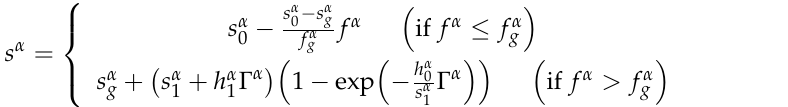
Figure 8. Comparison of the experimental and simulated response of the AZ31B Mg alloy during uniaxial loadings along the rolling direction. ( a ) Stress ‐ strain curves of uniaxial tension and com ‐ pression, ( b ) twin volume fraction of uniaxial compression (After Wu et al. [105]). 2.4. Detwinning In the case of more complex strain paths, the detwinning mechanism should also be included in addition to twinning and slip modes. Various models address the detwinning along twinning and slip modes using crystal plasticity [22,87–89,94–97]. Here, a physi ‐ cally ‐ based Twinning ‐ Detwinning (TDT) model is elaborated, which was developed by Wang and his coworkers [90–92] for the EVPSC framework and extended later on for the CPFE framework [9]. In this model, the twinning and detwinning mechanisms can be di ‐ vided into 4 major operations as follows (Figure 9):